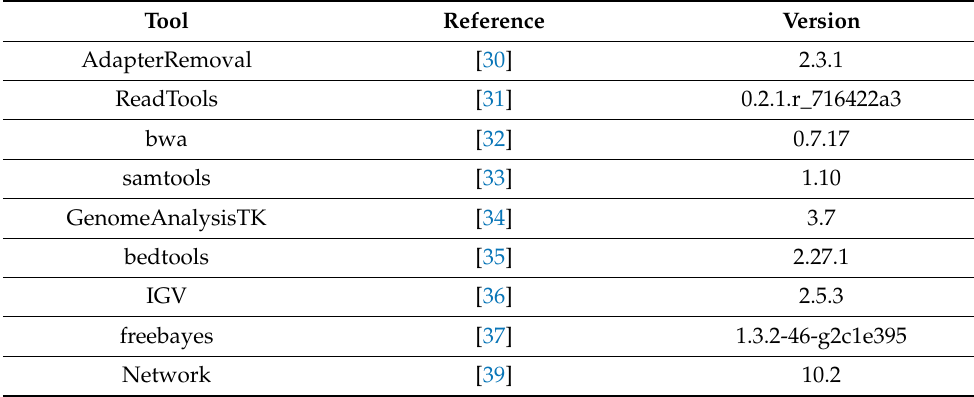
Figure A2. NGS data analysis pipeline. Two NGS data sets were merged to produce the final structure: mappings of 118 WGS males to LipY764 from a previous study and newly generated TES data of 39 males. The 77 novel variants ascertained in the TES dataset were merged with 2199 previously defined variants resulting in a total of 2267 variants. Those variants were genotyped in the mapping files, missing positions imputed, and HTs constructed by concatenating the polymorphic sites. HTs were visualized in a network format. A total of 118 variants was selected for genotyping. Detailed descriptions of the workflow, including programs, and parameters, is provided in the Material and Methods section. Table A2. Versions of the NGS tools used in data